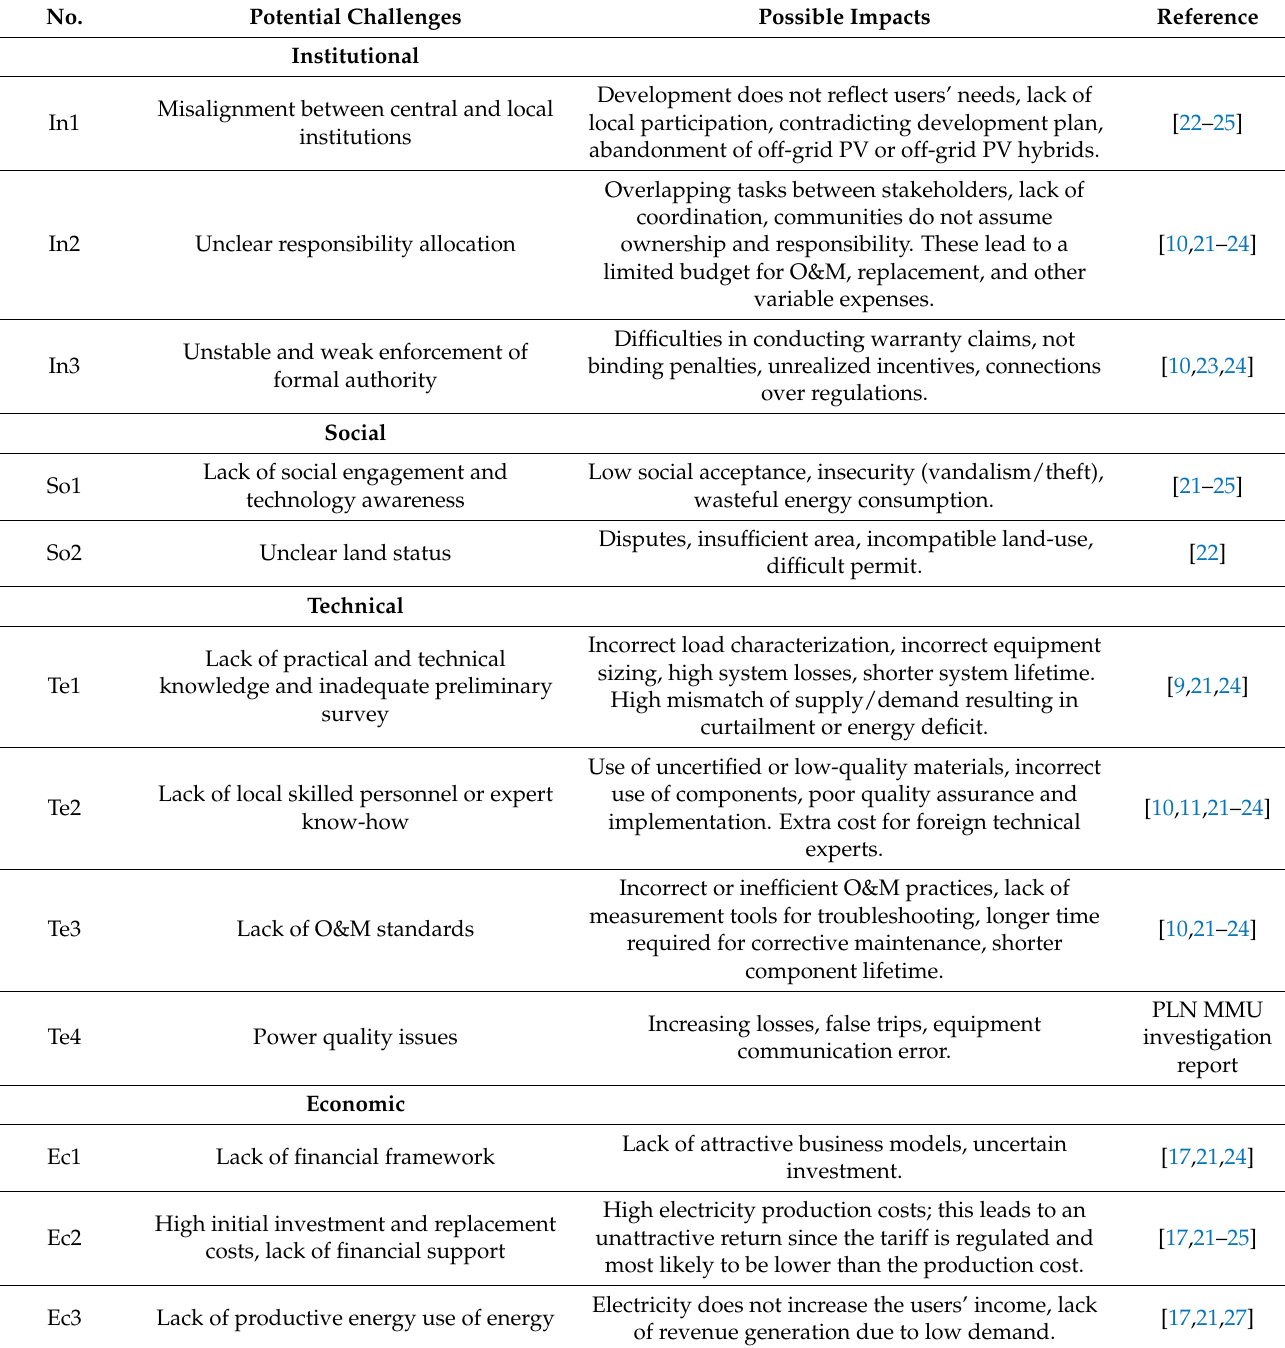
Table 3. Multi-dimensional scaling and sustainability challenges in remote microgrid development that are relevant for